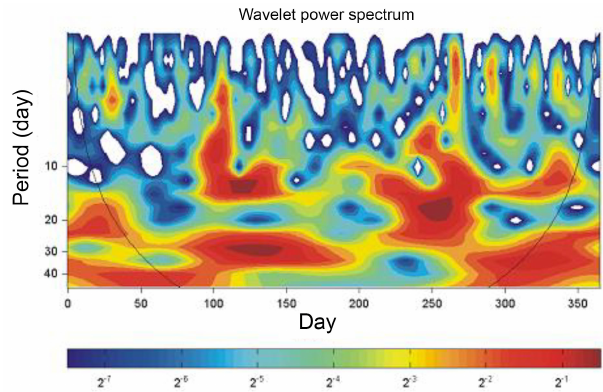
Figure 7. Planetary wave activity inferred from fo F2 for Pr˚uhon- ice, January–December 1980 with Morlet wavelet and Fourier spec- trum: horizontal axis – power; vertical axis – period of oscillations in days (Bremer et al.,